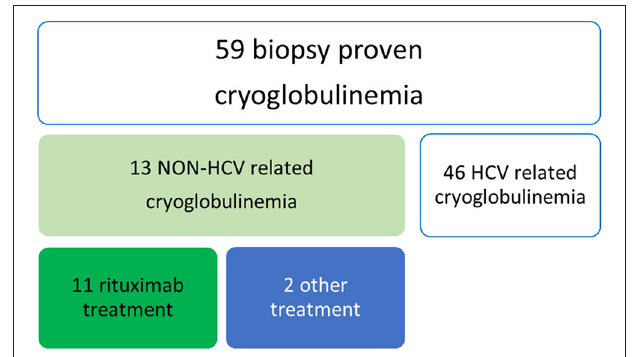
FIGURE 1 | Algorithm for patient